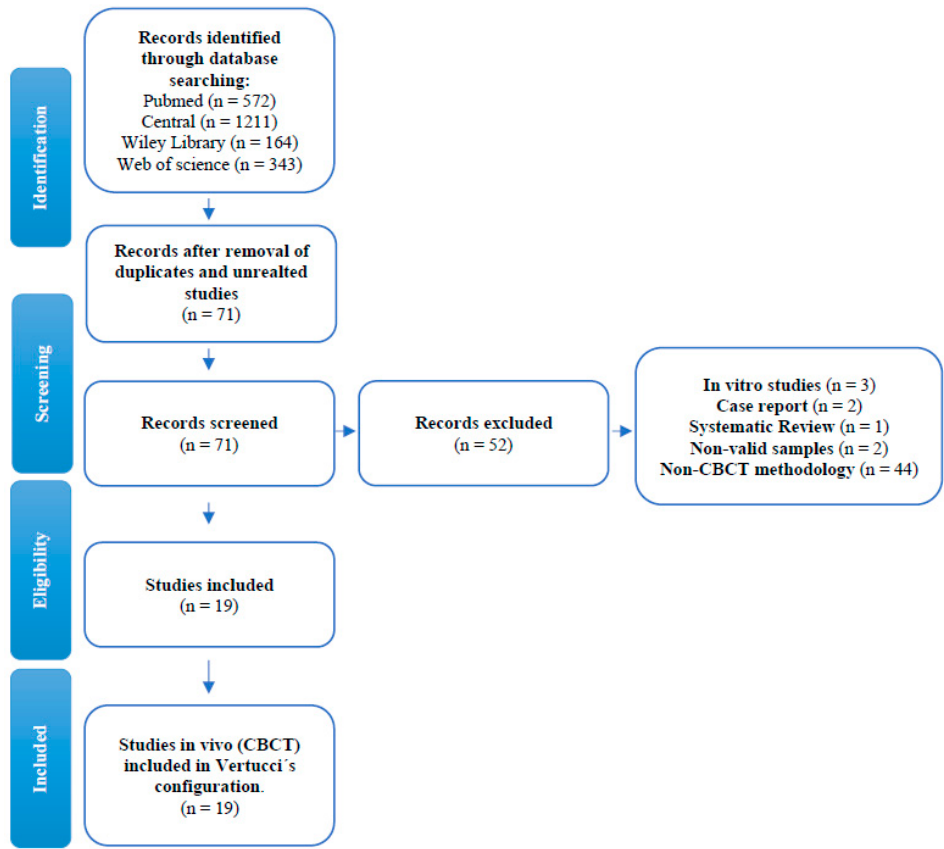
Figure 3. Flowchart of the study selection process. PRISMA (Preferred Reporting Items for Systematic Review and Meta-Analyses) [17].